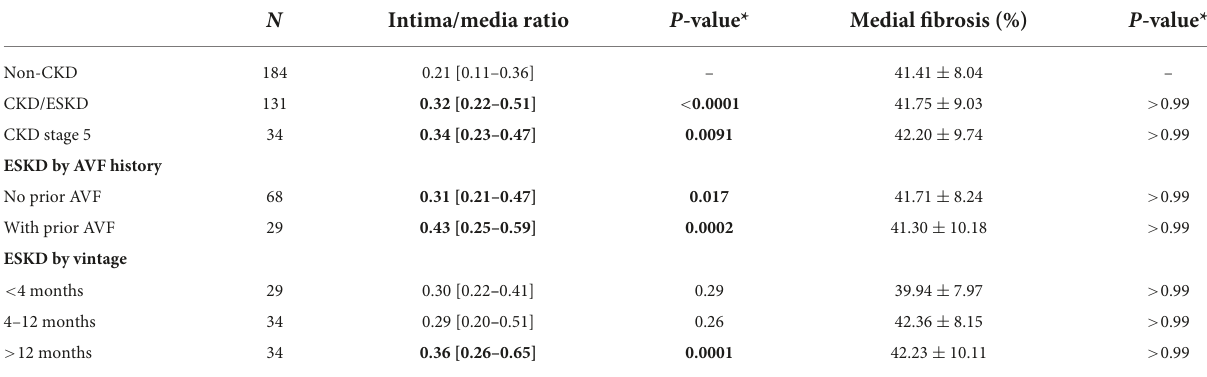
TABLE 2 Morphometric comparisons between the CKD/ESKD and non-CKD